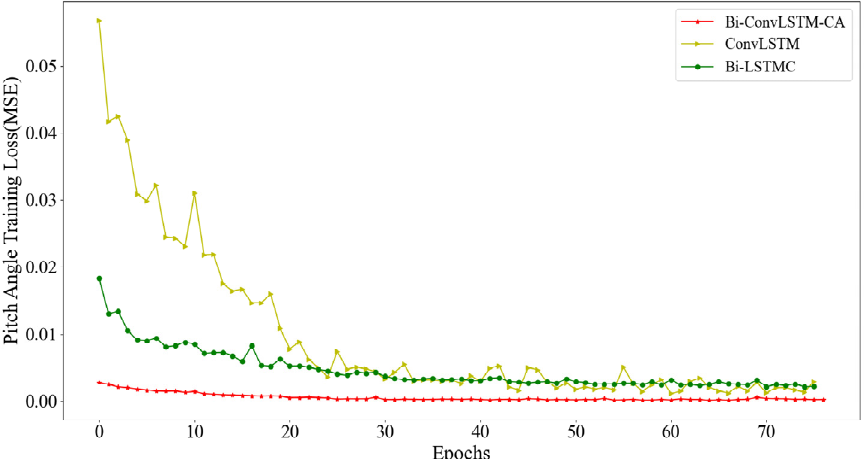
Figure 10. Training error plot of each deep learning model.